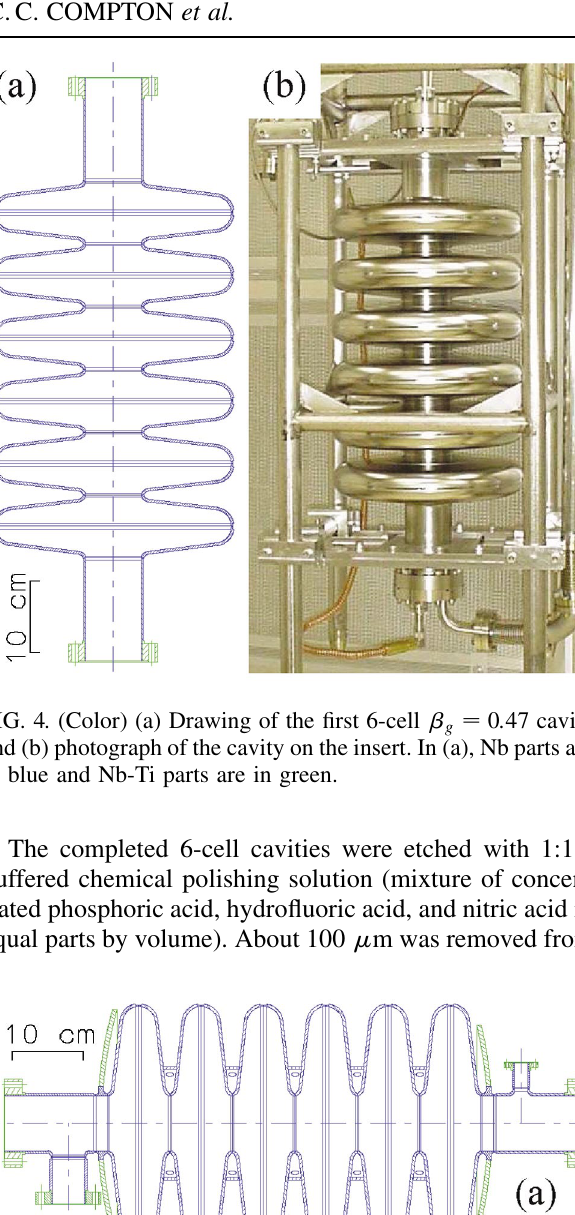
FIG. 4. (Color) (a) Drawing of the first 6-cell (cid:6) and (b) photograph of the cavity on the insert. In (a), Nb parts are in blue and Nb-Ti parts are in